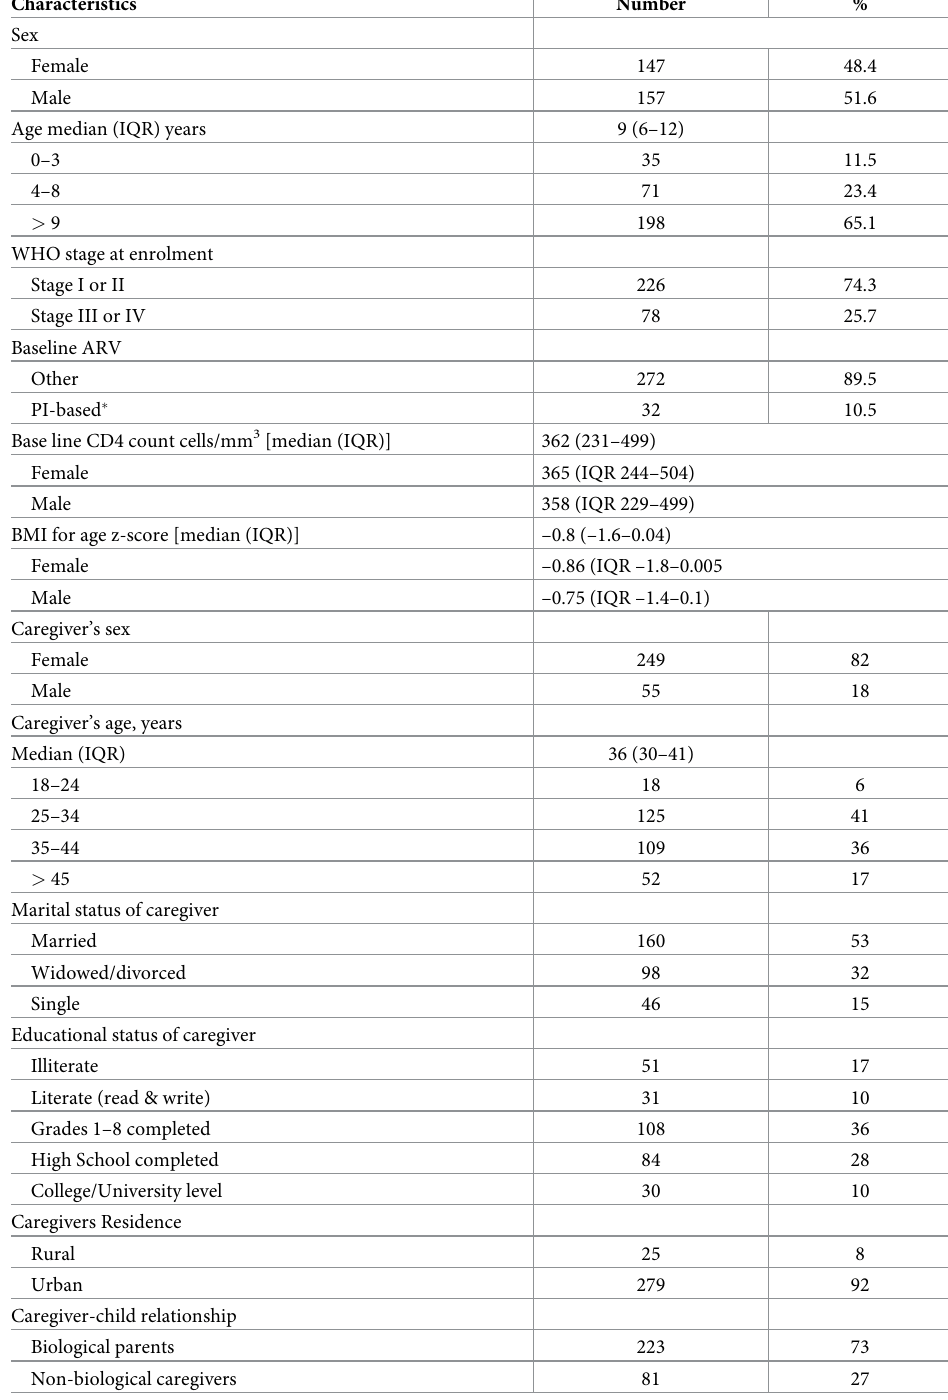
Table 1. Baseline characteristics of study participants,